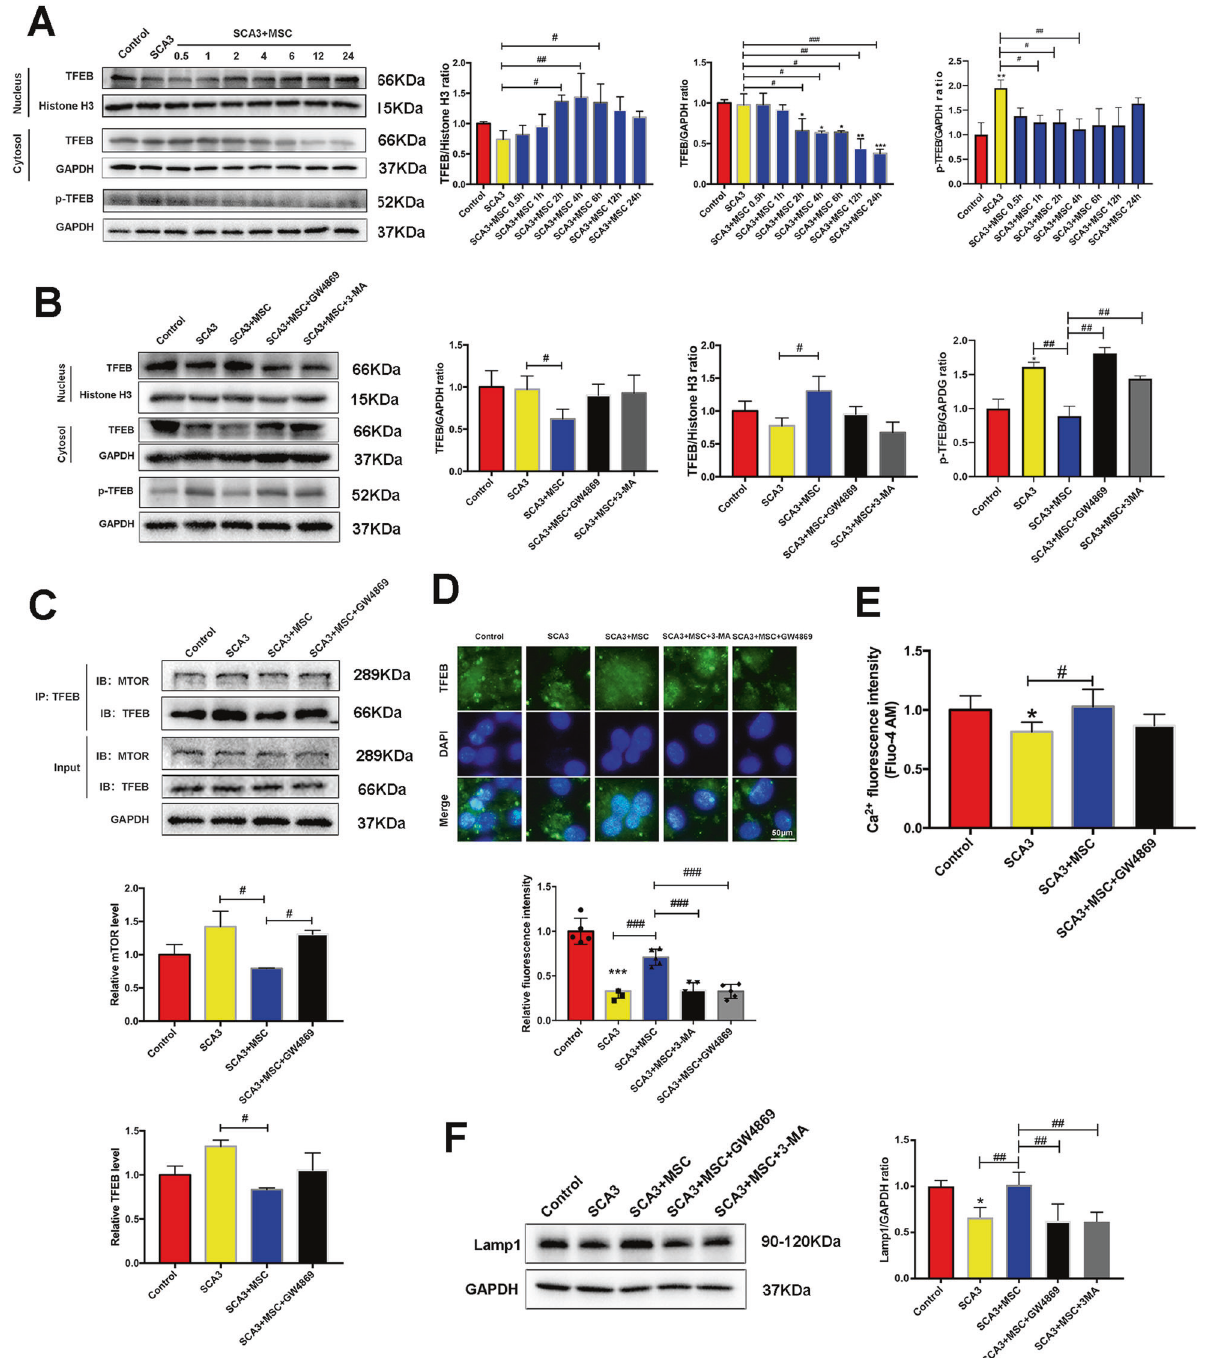
Fig. 3 MSCs induced TFEB nuclear translocation in neuronal cells of SCA3 patients. A The expression of TFEB and p-TFEB at different treatment times in the cytoplasm and nucleus after MSCs therapy. B The effects of GW4869 and 3-MA on the expression of TFEB and p-TFEB in the cytoplasm and nucleus after MSCs therapy. C Co-IP assay for mTORC1-TFEB interaction. D TFEB and DAPI co-localization after MSCs by immuno fl uorescence (scale bar: 50 μ m). E The detection of Lysosomal Ca 2 + release into the cytoplasm after MSCs therapy. F The expression levels of Lamp1. * p < 0.05, ** p < 0.005, *** p < 0.001 vs Control group, # p < 0.05, ## p < 0.01, ### p <